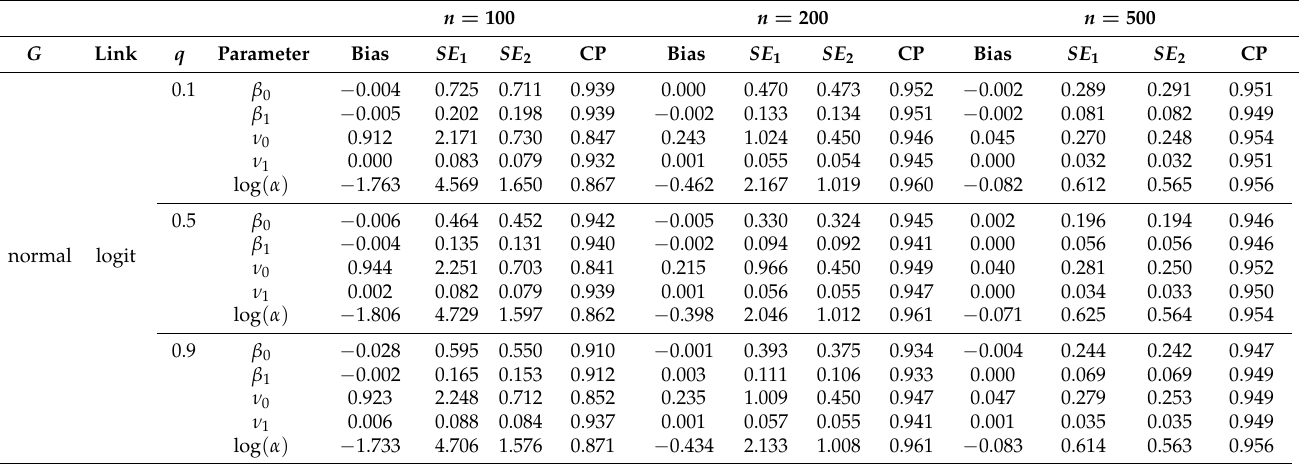
Table 3. Estimated bias, standard error of the estimated parameters ( SE 1 ), the mean of the estimated standard errors ( SE 2 ), and 95% coverage probabilities (CP), when G and the link are correctly specified (case G is the cdf of the normal